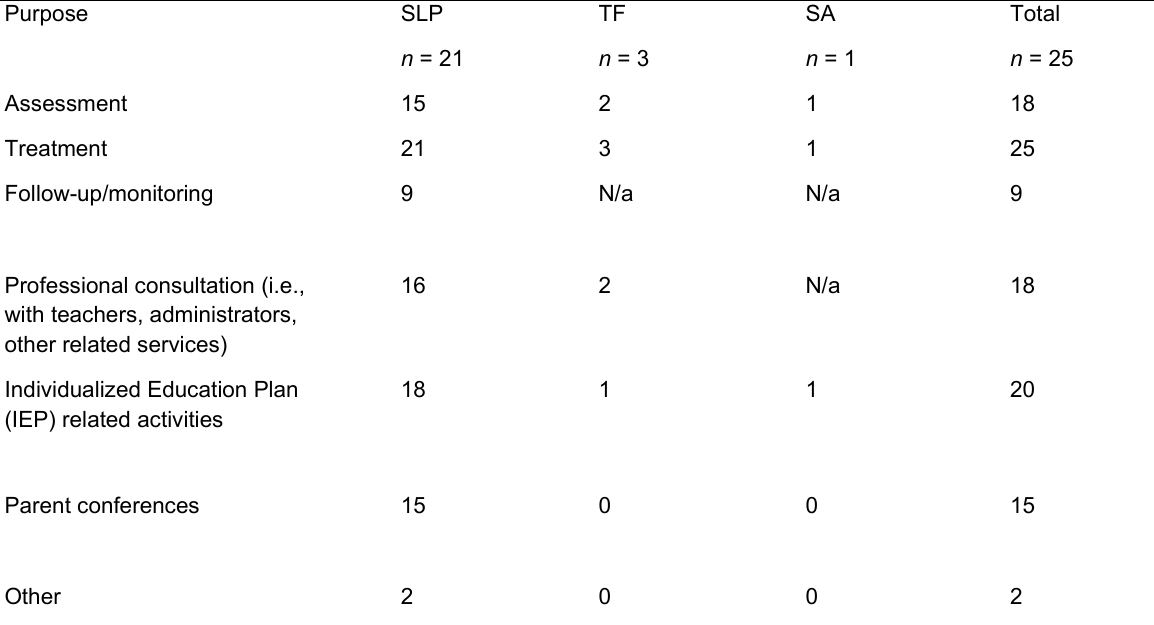
Participants’ Use of Telepractice Purpose